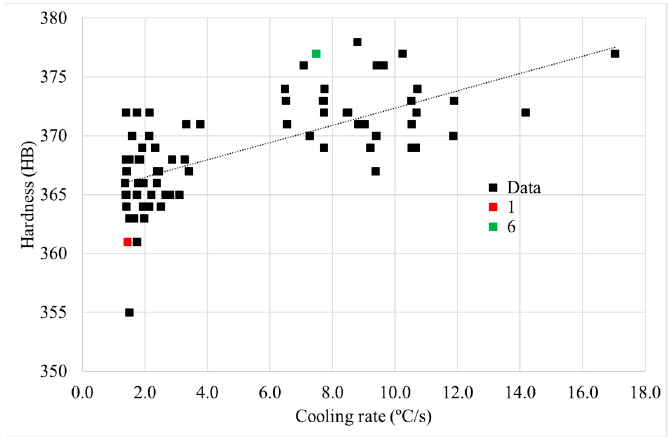
Figure 20. Relationship between solutioning cooling rate and hardness after HT-A.